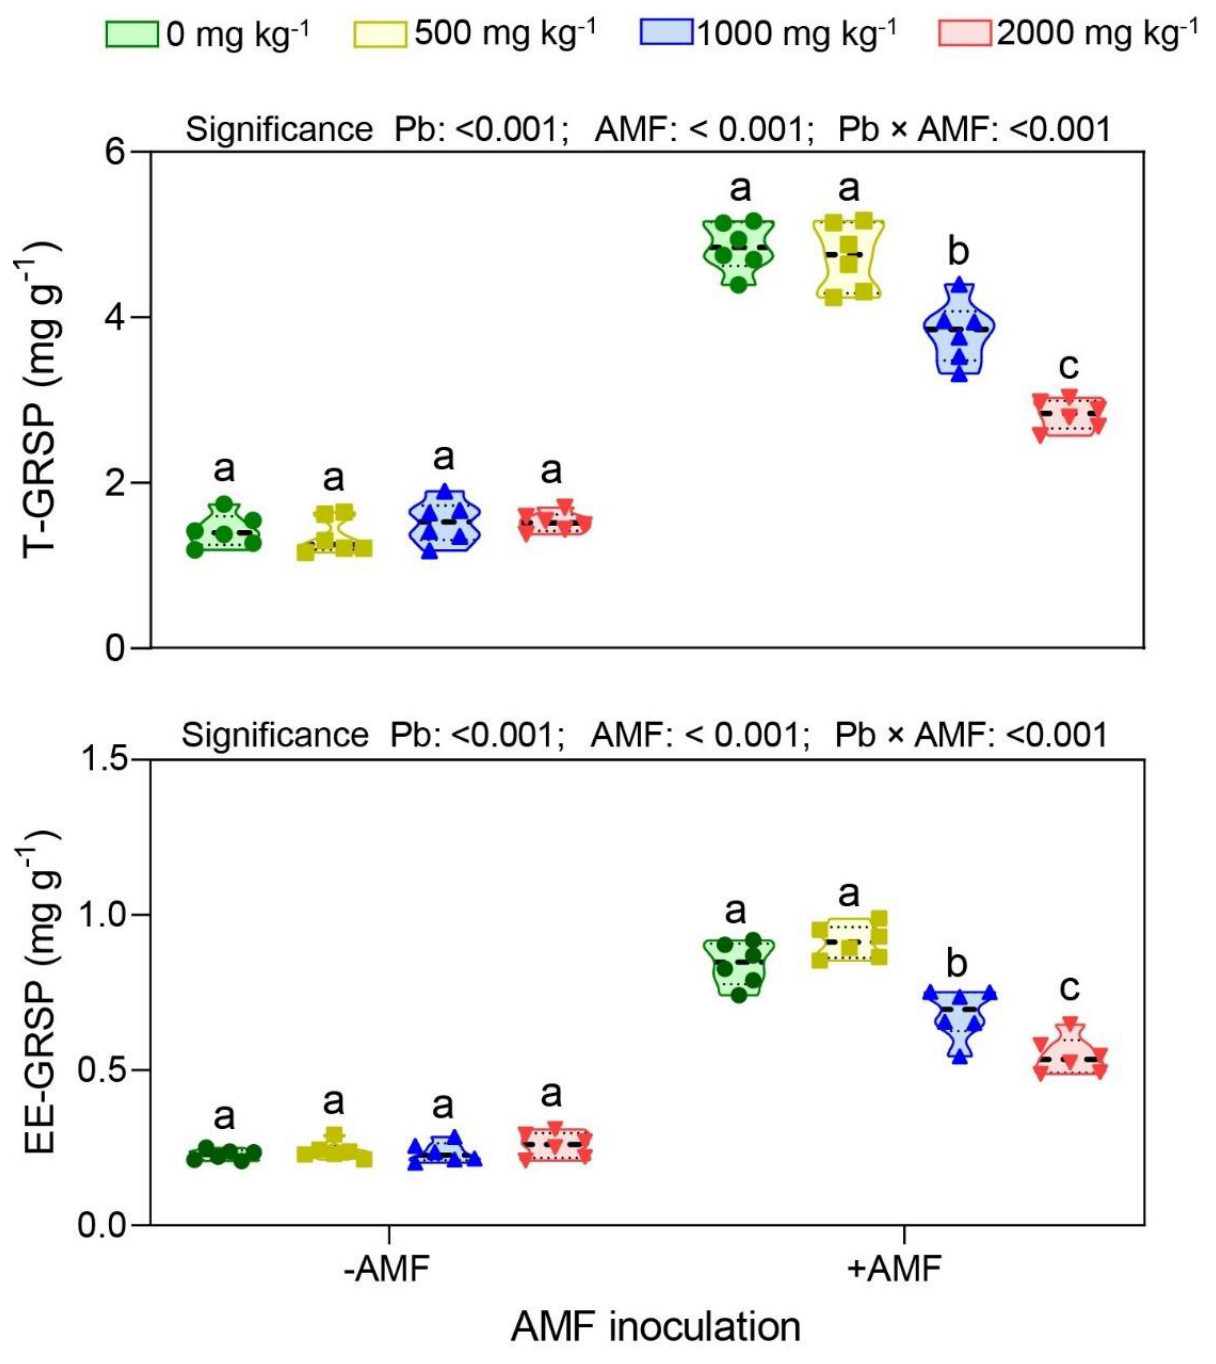
Figure 3. Total glomalin-related soil protein (T − -GRSP) and easily extractable glomalin-related soil protein (EE − GRSP) contents under different treatments. Non-AMF inoculation ( − AMF); AMF inoculation (+AMF); Pb − stress level (0, 500, 1000, and 2000 mg kg − 1 ). Data represent mean ± SD for biological replicates ( n = 6). The same letter indicates no significant difference (Duncan’s test, p < 0.05).